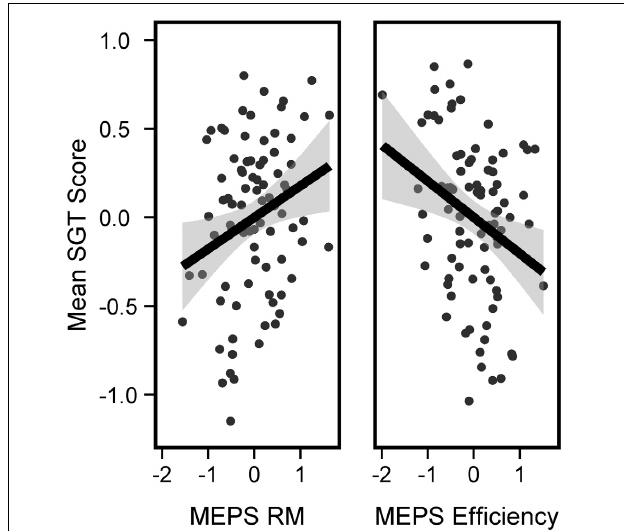
FIGURE 5 | Link between MEPS and WM performance. Participants with poor WM performance also had poor MEPS performance (low efficiency, low RM). We performed median splits on Efficiency and RM scores and computed a measure of mean WM performance for each of the 4 groups of participants (both low efficiency and RM, both high efficiency and RM, low efficiency-high RM, high efficiency-low RM). Error bars represent standard error of the